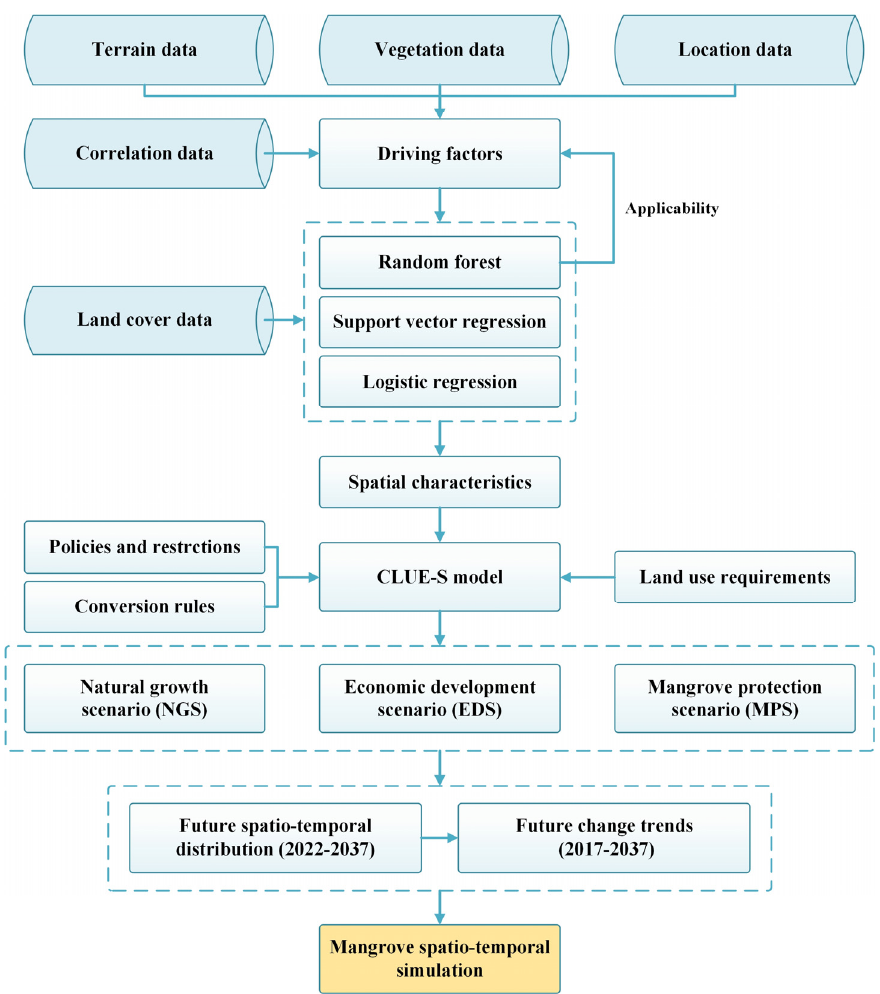
Figure 2. Flowchart of the spatio-temporal simulation of mangrove forests.